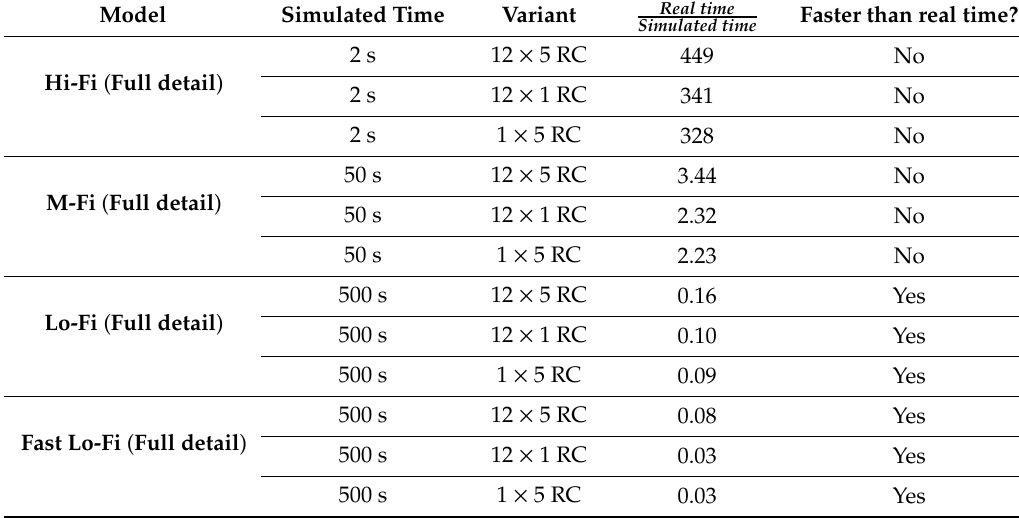
Table 8. A speed comparison of the thermal models, where the relation between the real time and simulated time is